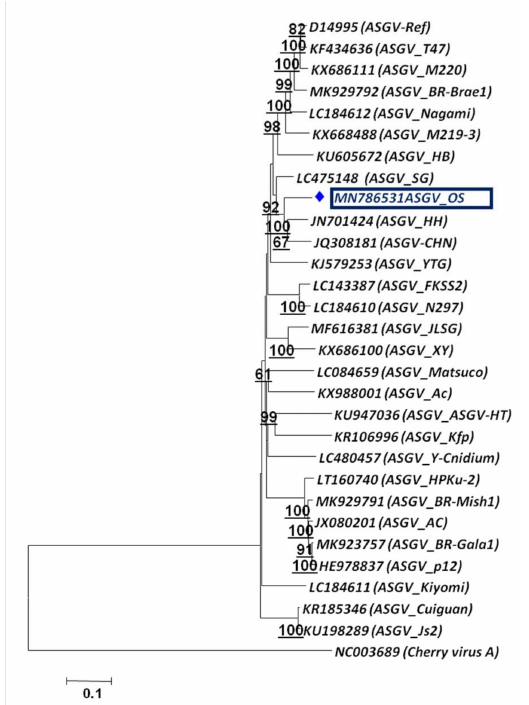
Figure 7. Phylogenetic relationship of apple stem grooving virus based on whole-genome sequence alignment through NJM at 1000 replications for each bootstrap value using MEGA 7.0; our ASGV isolate is highlighted with color in phylogeny. Cherry virus-A (CVA) represents